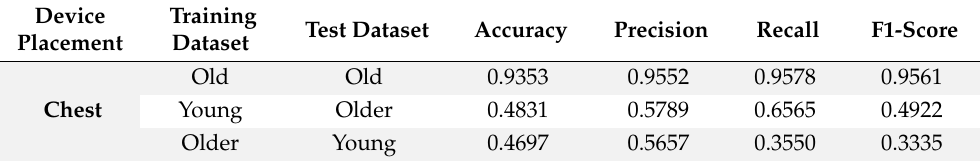
Figure 6. Confusion matrices obtained from the purposed LSTM model. ( a ) Trained on older adult chest data, tested on older adult chest data; ( b ) trained on young chest data and tested on older adult chest data; ( c ) trained on older adult chest data, tested on young chest data. Table 4. Comparison of average accuracy, average precision, average recall, and average F1-score of models trained on older adult chest data and tested on older adult chest data, trained on young chest data and tested on older adult chest data, and trained on older adult chest data and tested on young chest data, respectively.